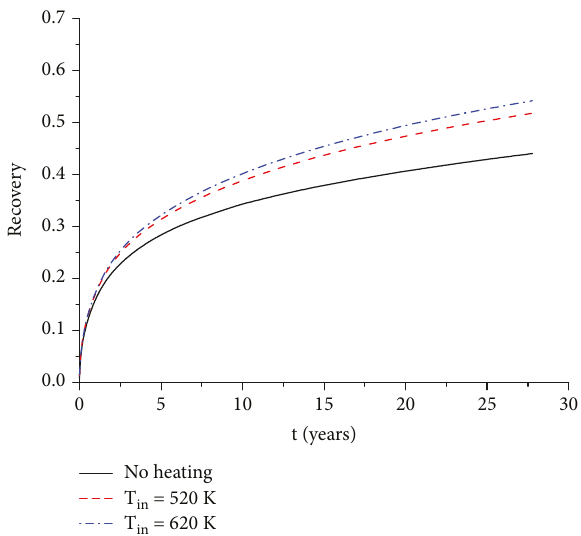
Figure 15: E ff ect of thermal stimulation temperature on shale gas recovery.